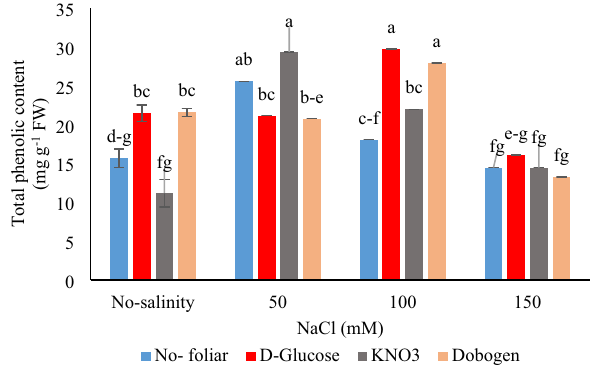
Figure 2. Interaction effects of salinity (0, 50, 100, and 150 mM NaCl) and foliar applications (no-foliar, 2 g L −1 glucose, 2 g L −1 KNO 3, and 2% Dobogen biostimulant) on the total phenolics content of Tanacetum balsamita plants grown in perlite. Significant differences among treatments are indicated by different Latin letters according to Duncan’s multiple range test.